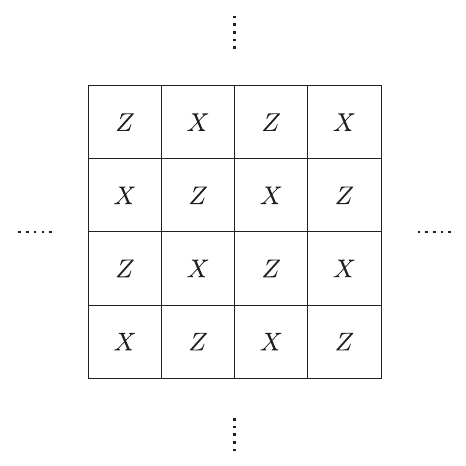
FIG. 5. Rotated version of the toric code. Here, X s ( Z s) represent the stabilizers, each of which is a tensor product of